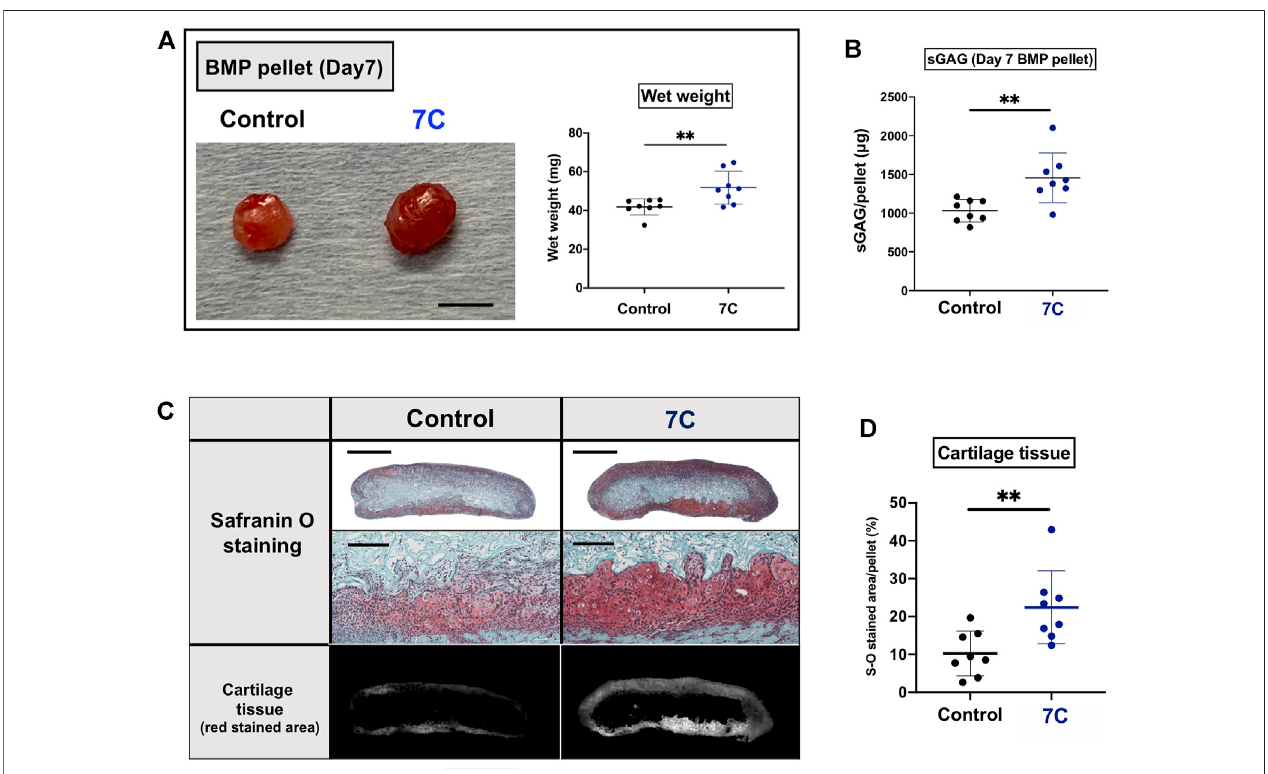
FIGURE3 | Evaluation ofcartilage componentsin BMP pellets on Day 7. (A) Macroscopic appearance and wet weight ofthe BMP-2 pellets with 7C-NPs (7C) and blank-NP(Control)(scalebar=5 mm). (B) ThesGAGamountintheBMP-2pellets. (C) SafraninOstainingoftheBMP-2pellets(wholeview,scalebar=1 mm;magni fi ed view, scale bar = 200 μ m). (D) Comparison of cartilage tissue area. The red stained area was measured using ImageJ (version 1.52q, U. S. National Institutes of Health; https://imagej.nih.gov/ij/). n = 8 per group, ** p < 0.01.